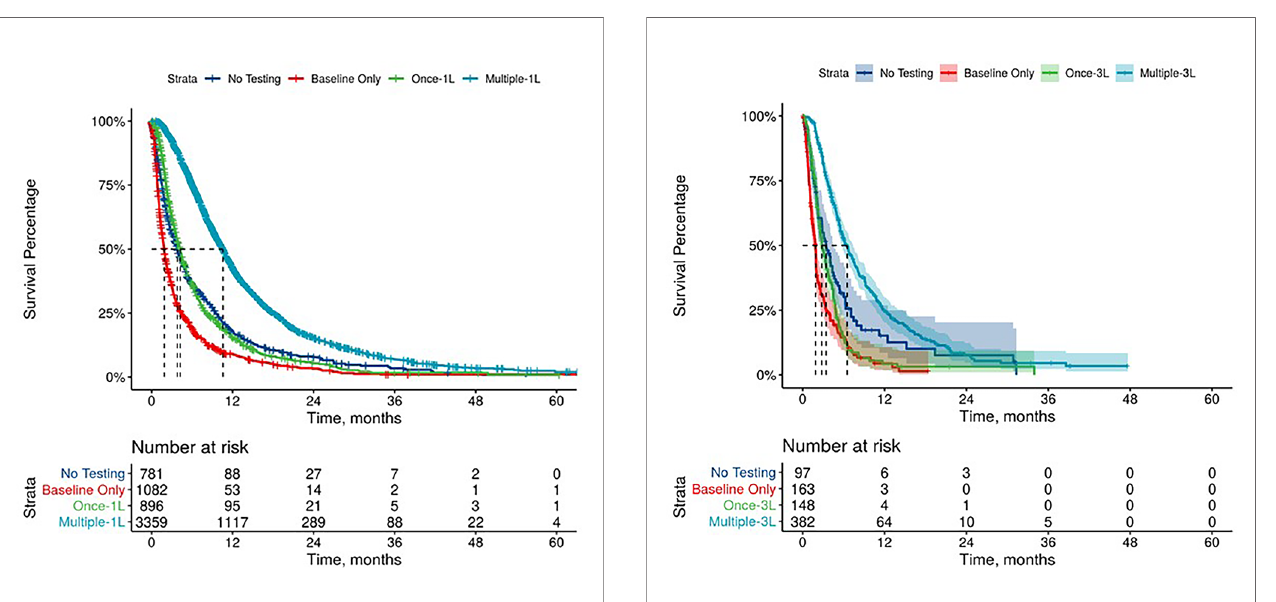
FIGURE 4 | Overall Survival by Carbohydrate Antigen 19-9 Testing Status among patients treated in third line.